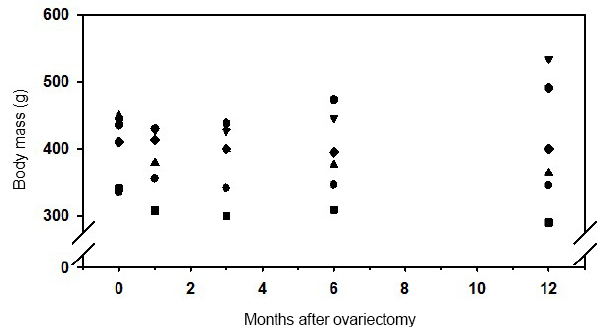
Figure 3. Body mass of six female marmoset monkeys before and during 12 months after